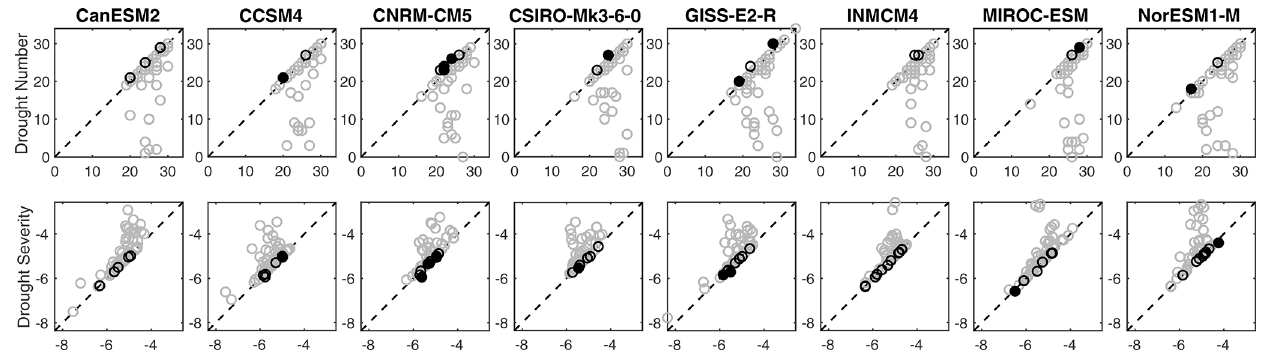
Figure B4. Scatter plot showing number of droughts (top row) and drought severity (bottom row) for SPEI G on the y -axis and SPEI N on the x -axis. Each column is a single GCM and each dot represents a single basin. Black-outlined points indicate basins with negative buffering for the metric and GCM provided. Filled black points indicate basins with negative buffering across both metrics for the given GCM (what we describe as “true” negative buffering).